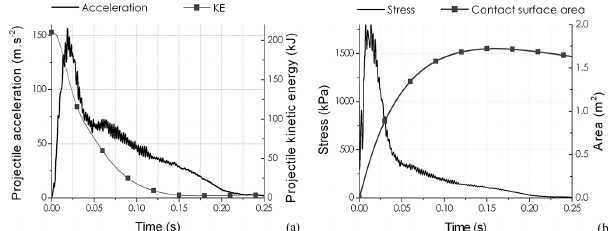
Figure 8. (a) Acceleration and kinetic energy of the projectile and (b) projectile/embankment contact surface and stress at the struc- ture’s front face during the 210kJ impact